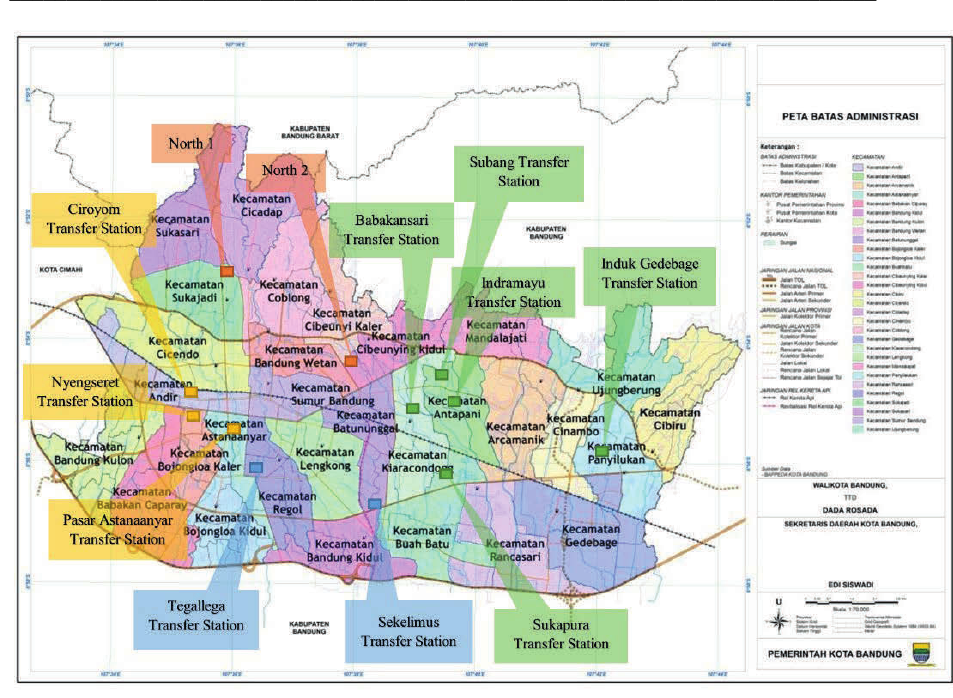
Fig. 5. Automotive shops’ hazardous waste collection system